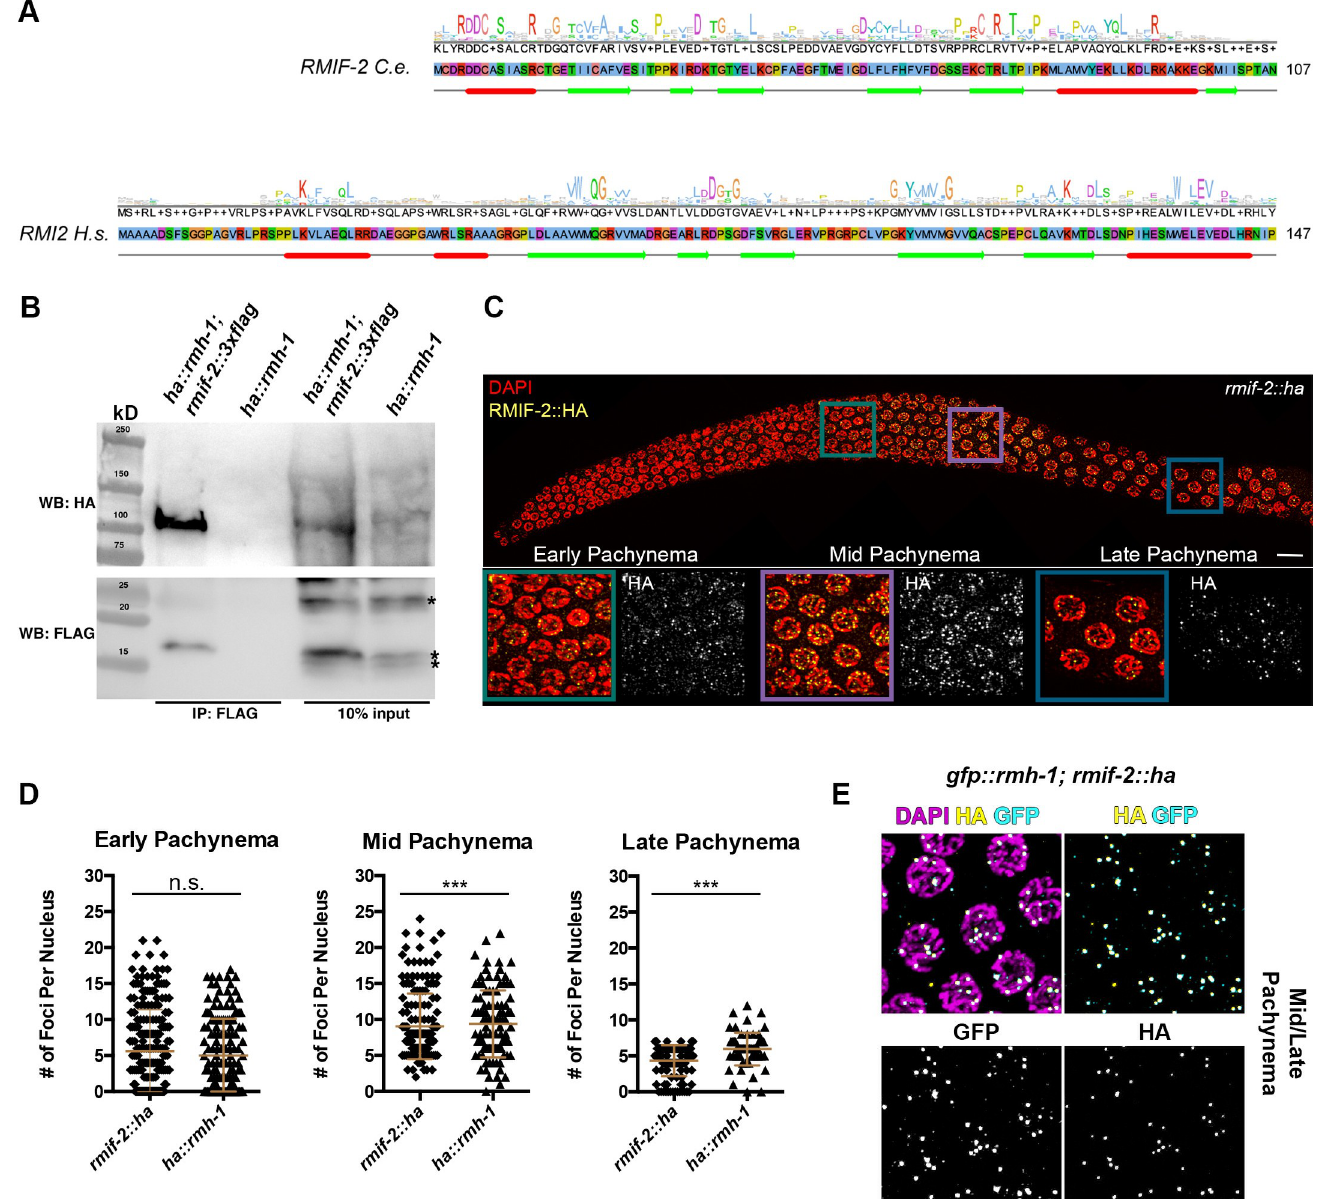
Fig 1. RMIF-2 as a functional homolog of RMI2. (A) A conservation histogram and consensus sequence (top lines), primary sequence (middle) and a secondary structure prediction (bottom line) of Caenorhabditis elegans RMIF-2 (UniProt accession Q8MXU4) and Homo sapiens RMI2 (Q96E14). In the case of RMIF-2, the conservation histogram and the consensus sequence are based on an alignment of nematode orthologs, and for RMI2 a wide selection of eukaryotic orthologs was used, including animal and plant sequences. Sequence letters were highlighted in the ClustalX color scheme to indicate amino acids with similar physicochemical properties. Secondary structure elements were predicted (Jpred), where the helices are marked as red tubes, and sheets as green arrows (JNETPSSM), [59]. Both families share the sequential arrangement of a five-stranded beta sheet and a c-terminal alpha helix. (B) Western blot analysis of FLAG pull downs revealed robust co-immunoprecipitation of HA::RMH-1 and RMIF-2::3 × FLAG. ha :: rmh-1 worms were used as the negative control. The predicted size of RMIF-2::3 × FLAG is 16 kD and HA::RMH-1 109 kD. IP, immunoprecipitation; WB, western blot. Asterisks indicate unspecific bands. (C) A Representative image of RMIF-2 foci localization throughout the C . elegans gonad (stained with DAPI in red and HA in yellow). Foci start to appear in early pachynema and increase in number throughout mid pachynema; in the late stages of pachynema, foci numbers are reduced. Scale bar: 10 μ m. (D) Mean numbers of RMIF-2::HA and HA::RMH-1 foci throughout pachynema: early pachynema, 5.6 ( ± 5.8 SD) RMIF-2 foci (n = 221) and 5 ( ± 5.1 SD) RMH-1 foci (n = 156 nuclei); mid pachynema, 9.0 ( ± 4.6 SD) RMIF- 2 foci (n = 184) and 9.4 ( ± 4.7 SD) RMH-1 foci (n = 106); and late pachynema, 4.3 ( ± 2.2 SD) RMIF-2 foci (n = 118) and 5.9 ( ± 2.3 SD) RMH-1 foci (n = 63); three gonads per genotype. Significant differences were determined using a Student T-test: ns = not significant ( p > 0.05); ��� p < 0.005. Data are the mean and standard deviation (error bars). (E) Representative images of C . elegans mid/late pachynema nuclei stained with DAPI (magenta), HA (yellow) and GFP (cyan). RMH-1 and RMIF-2 foci co-localize in mid–late pachynema nuclei. Scale bar: 10 μ m.